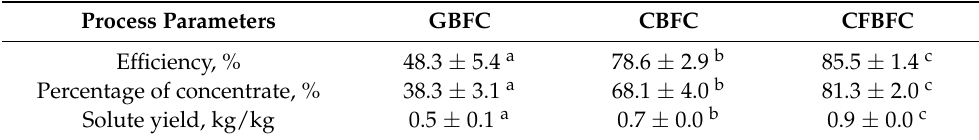
Table 3. Process parameters in the BFC